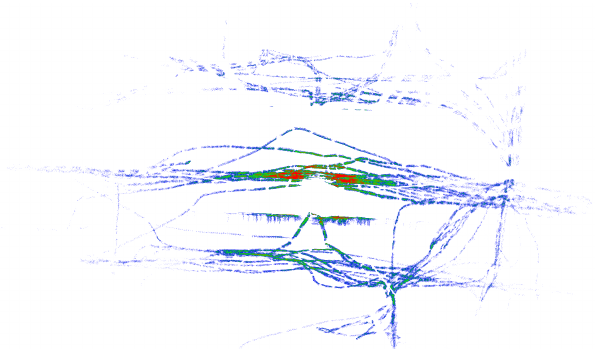
Figure 3: Moving object point accumulation image. Points are projected to an image showing the number of points in each pixel. Coloured from blue to green, to red as the pixel value increases. end, the tracklets from different temporal windows are connected so that the overall trajectories are recovered (Figure 5(c)).